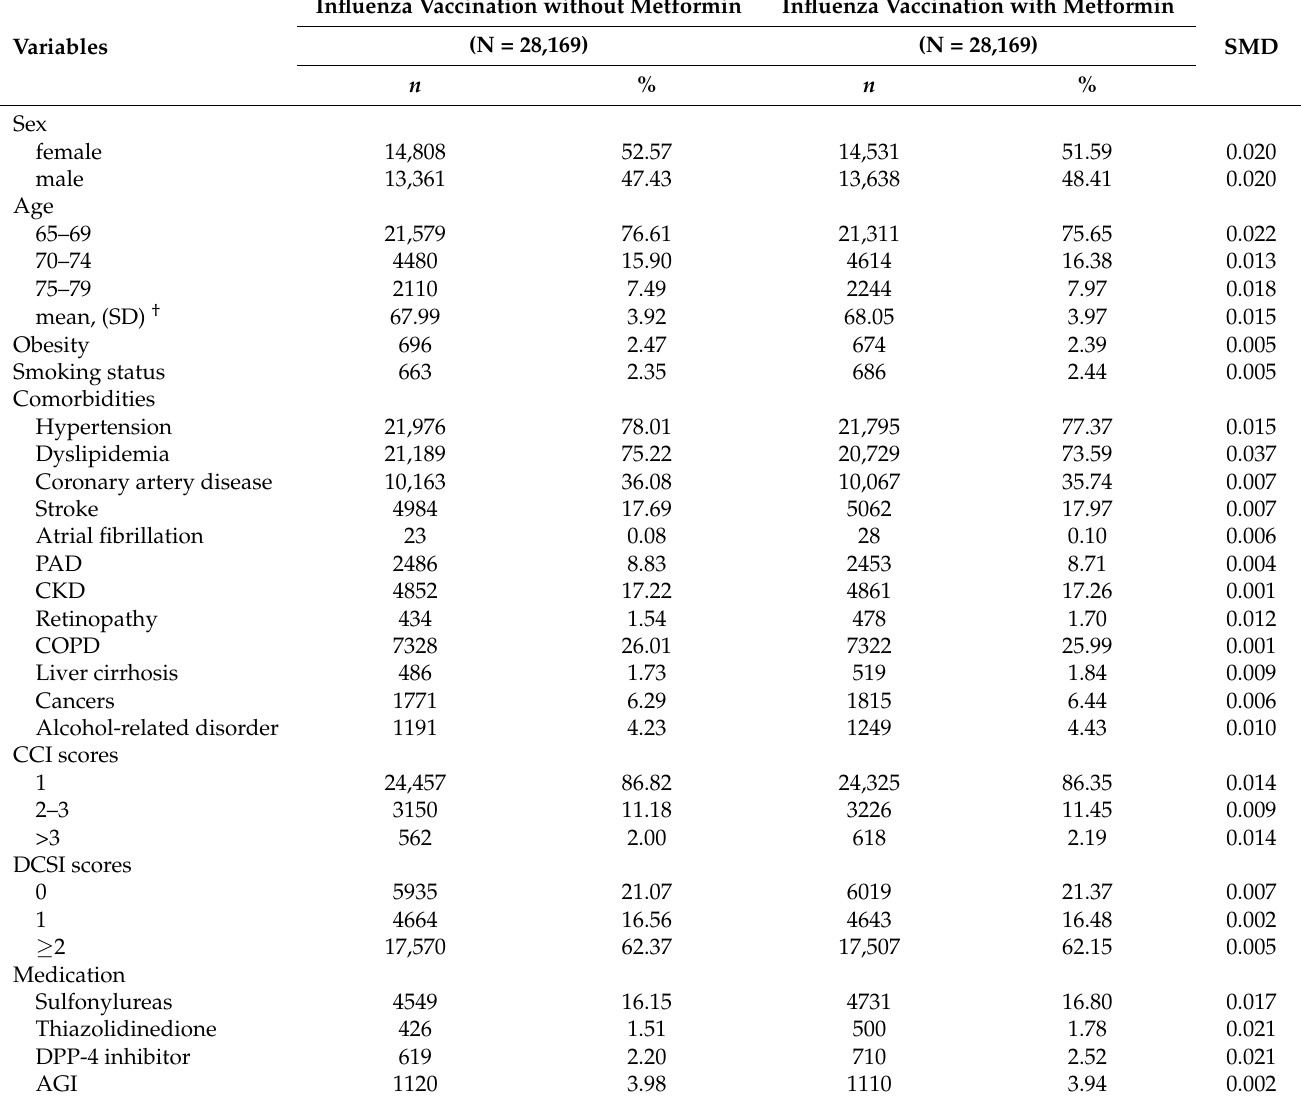
Table 2. Matched characteristics of patients with and without metformin use before influenza